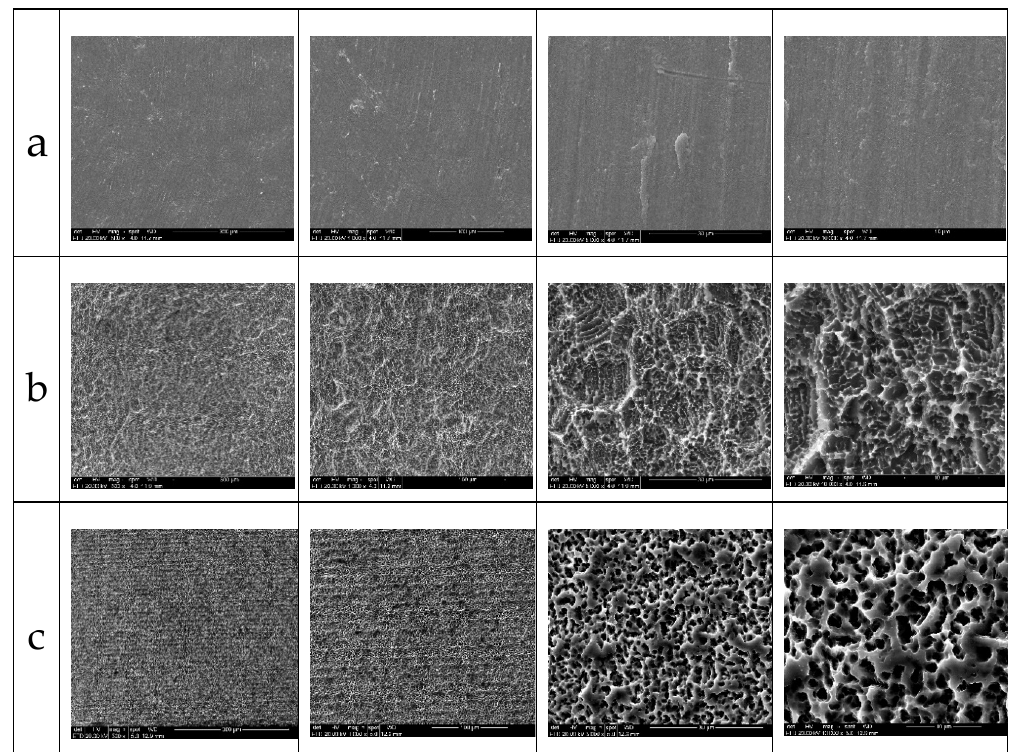
Figure 4. Representative sequence of SEM images of the surface samples of the G1 group ( a ), the G2 group ( b ) and ( c ) the G3 group at different magnification levels (500, 1000, 5000 and 10000×, respectively). The characteristics of the surface of each group can be observed in the AFM images (Figure 5).